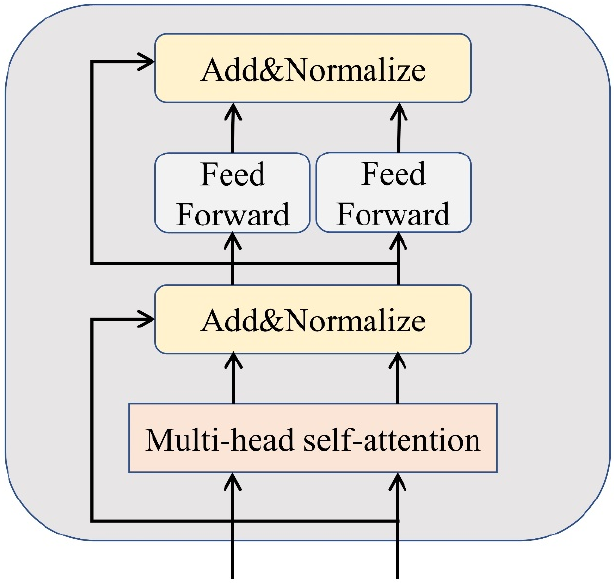
Figure 6. Encoder structure in the Transformer unit of the ERNIE model.